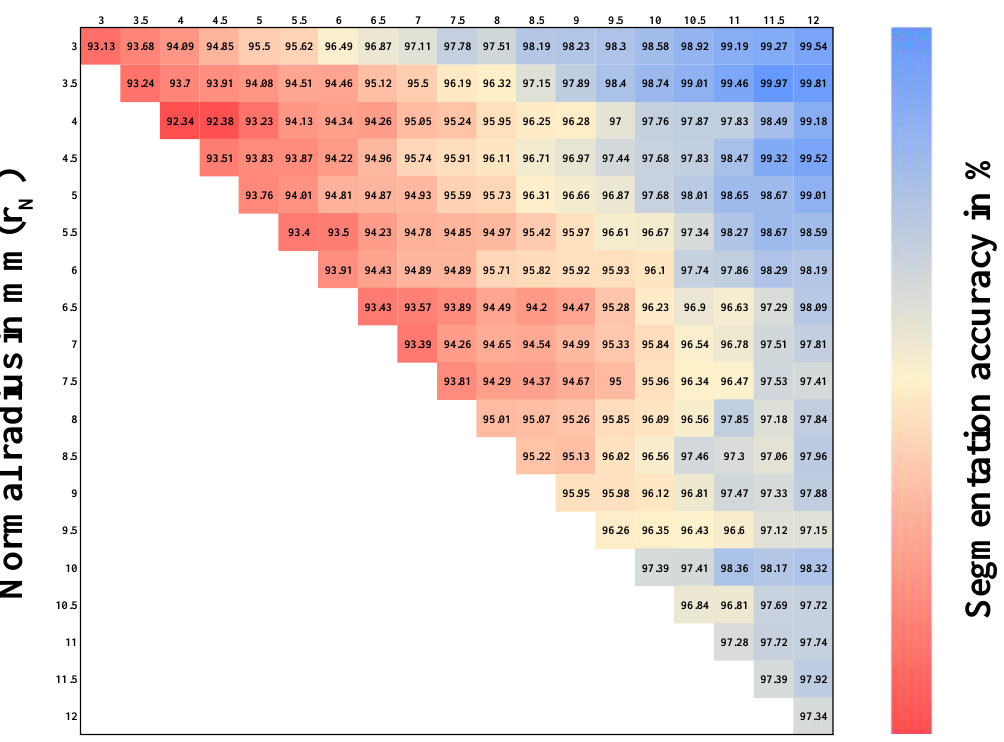
Figure 4. Heat map for segmentation results according to di ff erent histograms and normal radius for pre-processed point clouds with a resolution of 2mm.